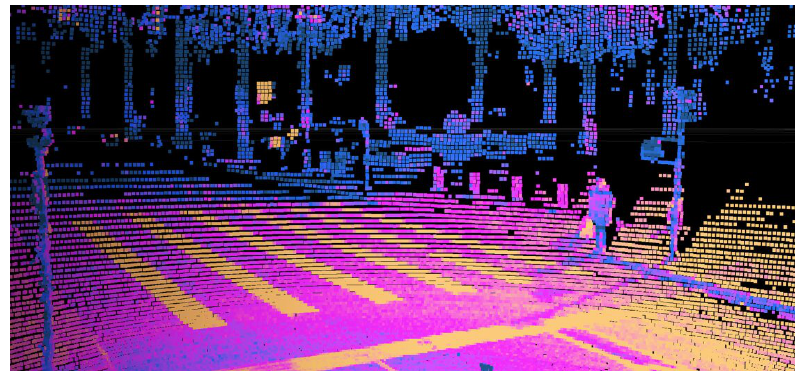
Figure 2. Pointcloud from Ouster lidar, Copyright © Ouster